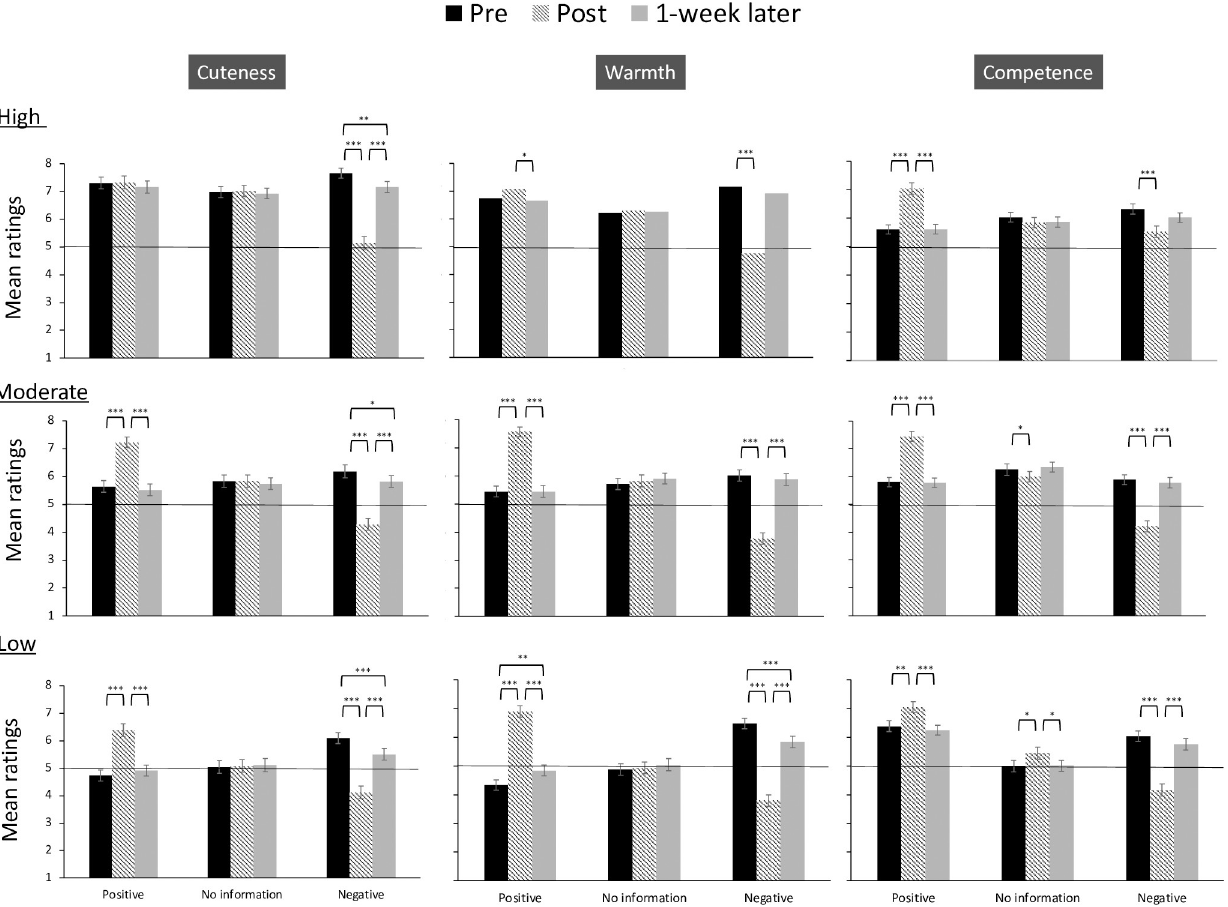
Fig 4. Cuteness, warmth, and competence ratings before/after the personality manipulation and 1 week later (Study 2). Error bars indicate standard error. The dotted lines indicate the midpoints. � p < .05, �� p < .01, ��� p < .001. High, moderate, and low indicate the levels of physical